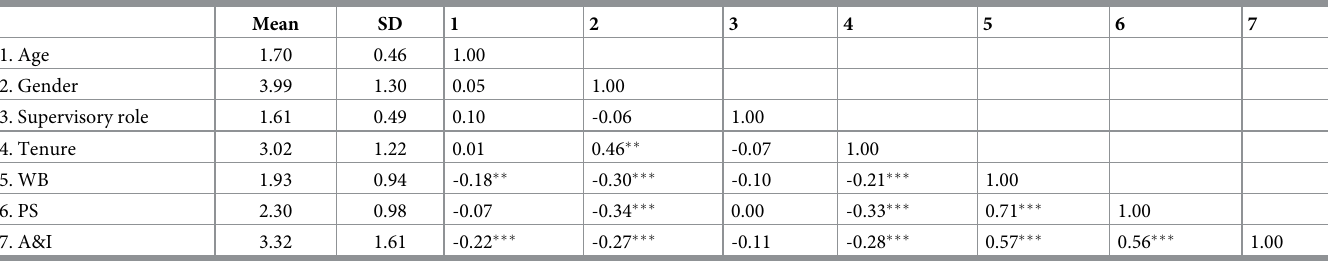
Table 2. Descriptive statistics and inter-correlations in Study